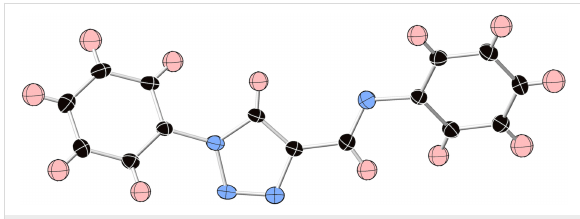
With the relative spontaneity of imine formation defined using symmetrical analogs, the study’s next focus was to examine how the substituent identity of both triazole and amine reac- tants influence the susceptibility of unsymmetrical